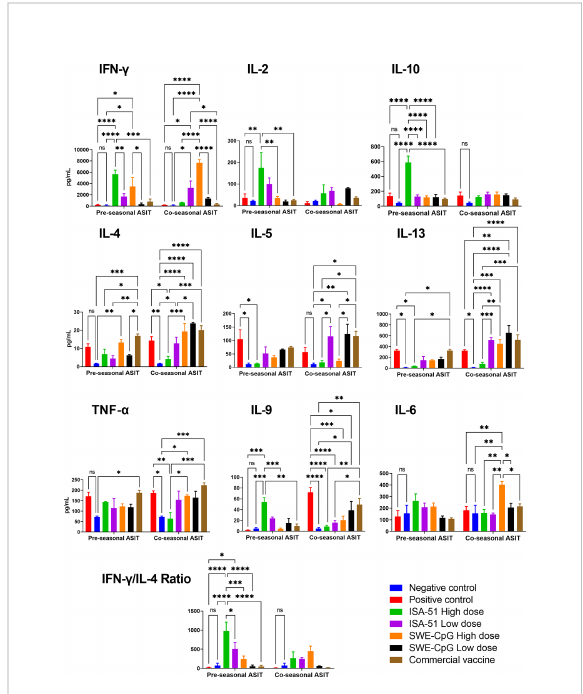
FIGURE 4 Art v 1 stimulated cytokine pro fi les in splenocytes of BALB/c mice after pre- and co-seasonal ASIT with different vaccine formulations. Cytokine data are presented as difference (delta) between samples with and without stimulation with Art v 1 protein and expressed in pg/mL. In addition, ratios between the IFN- g and IL-4 are presented to assess Th1/Th2 balance. Differences between groups were assessed using Tukey ’ s multiple comparisons test. NS - not signi fi cant. A P<0.05 value was considered a signi fi cant difference. *P <0.05, **P <0.01, ***P <0.001, and ****P